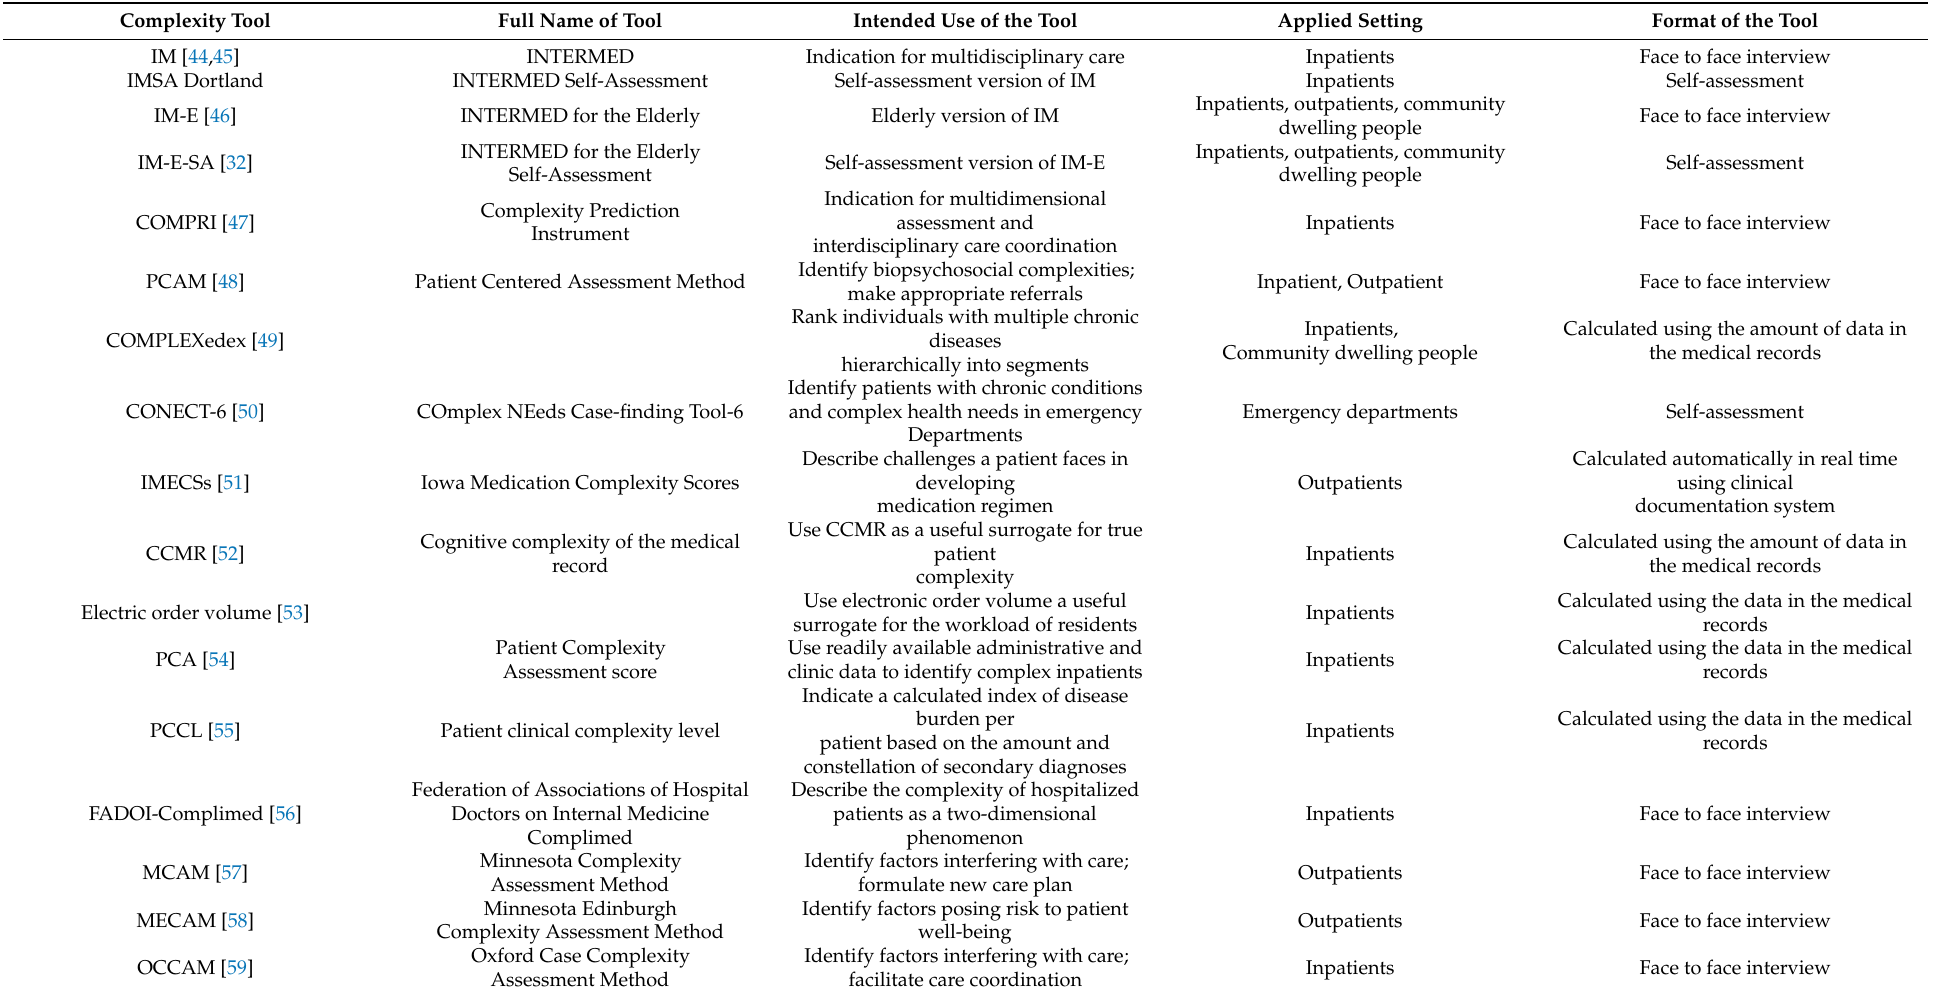
Table 2. Complexity measurement tools, intended use, applied setting, and